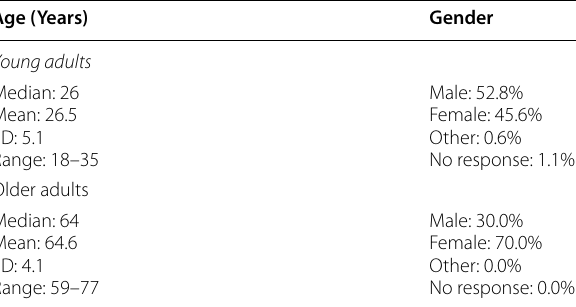
Table 1 Demographic details for our final samples of 180 young adults and 180 older adults